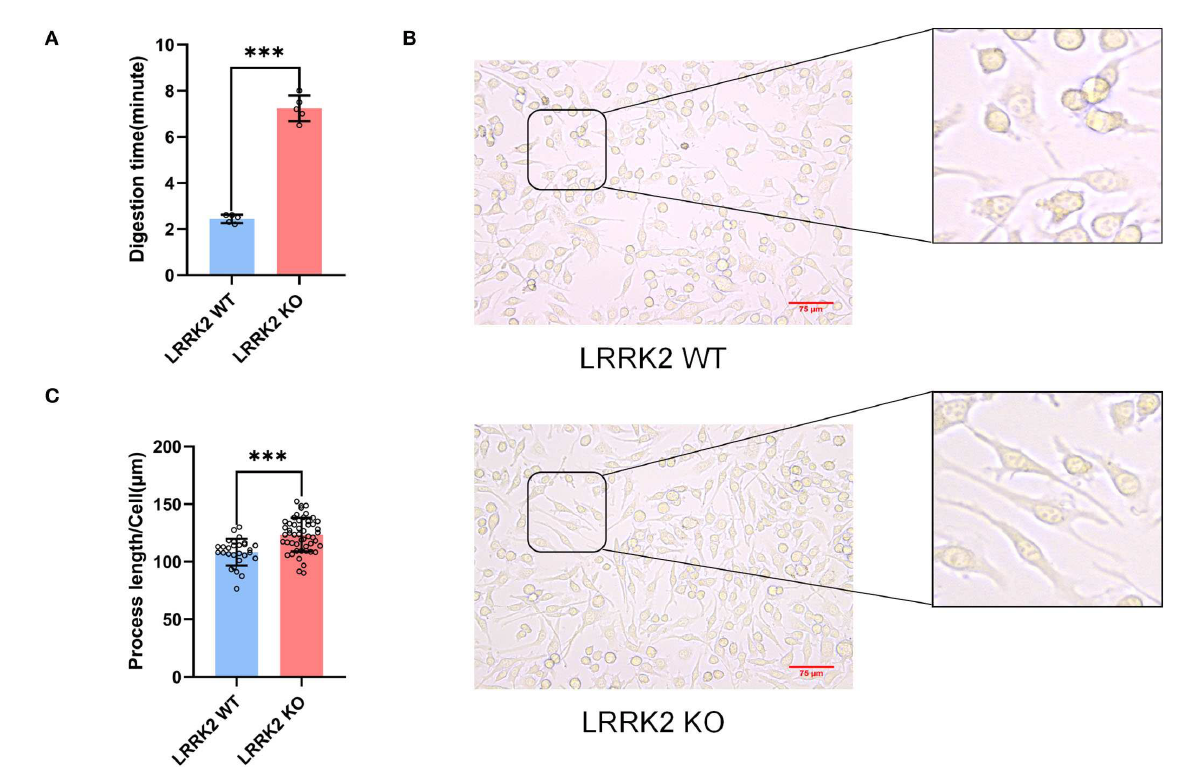
FIGURE4 Enhanced adhesion and lengthened process of microglia after LRRK2 knockout. (A) Statistics of the time required for trypsinization of LRRK2-WT microglia and LRRK2-KO microglia ( n = 5 experimental replicates, *** p < 0.001). (B) LRRK2-KO microglia showed significantly lengthened process ( n = 50 fields of view) when compared to WT ( n = 28 fields of view). Scale bars, 75 µ m. (C) Statistical analysis of the lengths of cell processes in (B) (*** p <